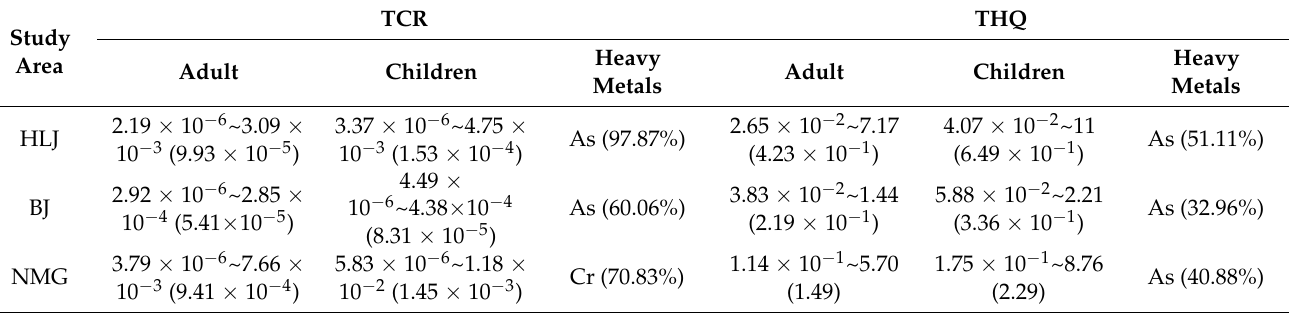
Figure 6. Total health risk and contributions of heavy metals. Total carcinogenic risk ( A ) and total non-carcinogenic risk ( B ). The red line is the average value. The black dotted line is carcinogenic risk values of 10 − 6 or 10 − 4 and HQ value of 1. Contributions of heavy metals in total carcinogenic risk ( C ) and total non-carcinogenic risk ( D ). Table 1. Total health risk and highest contributions of heavy